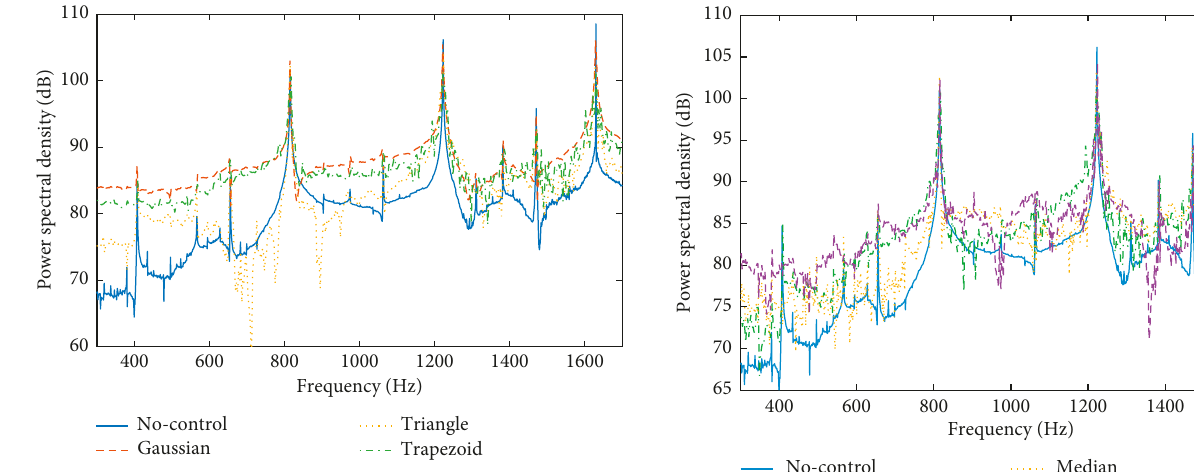
Figure 10: Frequency domain vibration active control of gear system based on different membership functions.